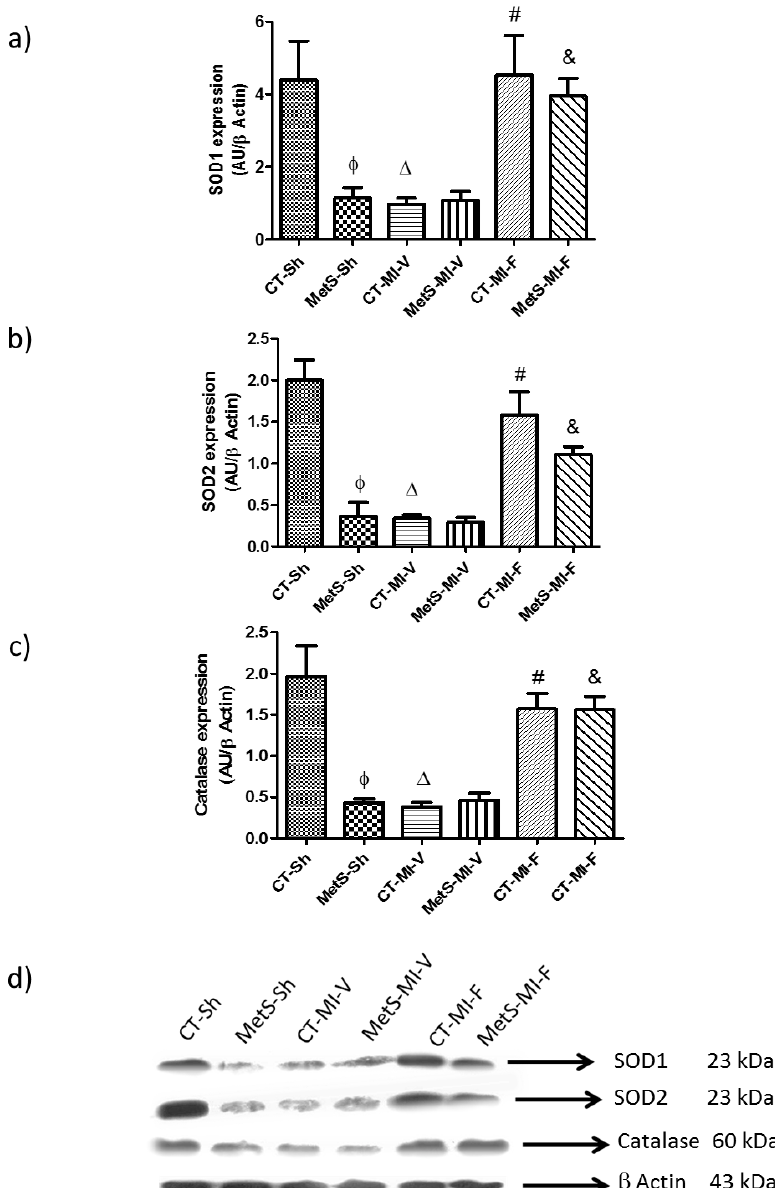
Figure 4. Expression of cardiac superoxide dismutase (SOD)1, SOD2 and catalase. Antioxidant enzymes were evaluated in the left ventricles from control and metabolic syndrome rats subjected to sham- or myocardial infarction and treated two weeks with either vehicle or fenofibrate. ( a ) SOD1 protein expression; ( b ) SOD2 protein expression; ( c ) catalase protein expression; ( d ) Representative immunoblot. Data represent mean ± SEM ( n = 5 per group). φ p < 0.05 vs. CT-Sh; Δ p < 0.05 vs. CT-Sh; # p < 0.05 vs. CT-MI-V; & p < 0.05 vs. MetS-MI-V. Analysis of variance-Tukey.